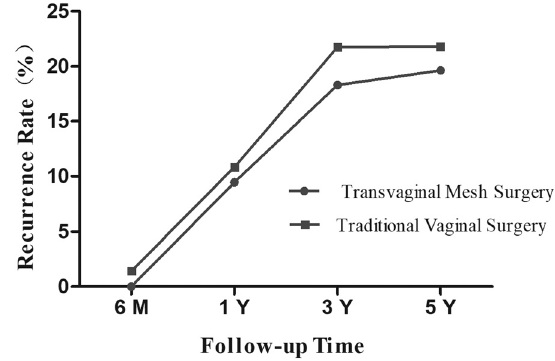
Figure 2: Comparison of the recurrence rate between the two groups with follow - up